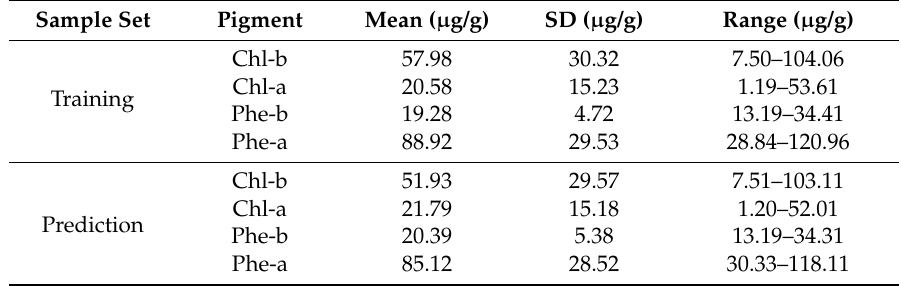
Table 1. Statistical analyses of the amounts of the four pigments in the validation and prediction sets. Sample